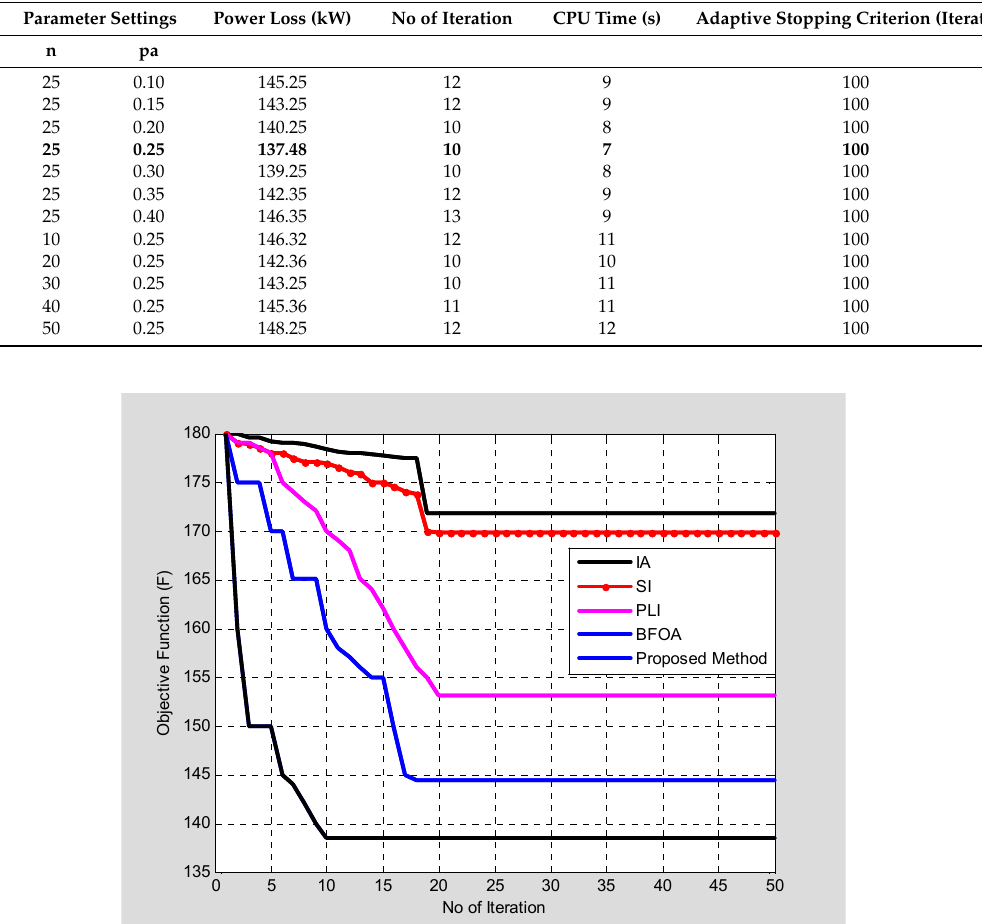
Figure 6. Comparison of Convergence characteristic of Objective Function for standard 33 Bus system.